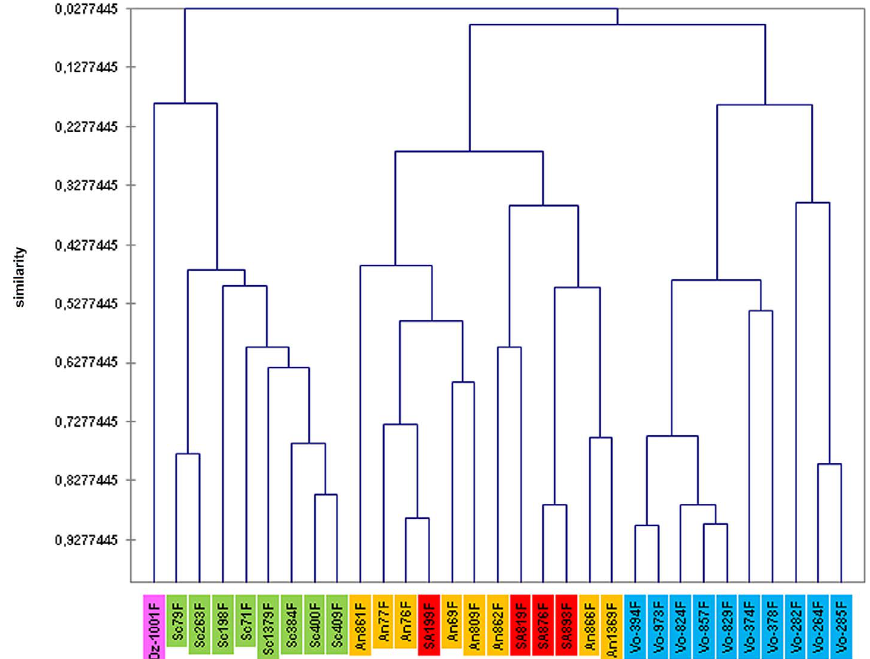
Figure 7. Hierarchical clustering based on morphometrical characters of females belonging to the following species Sc = Se. sclerosiphon ; An = Se. anka ; SA = Se. cf. anka ; Vo = Se. vol fi n. sp.; Oz = Se. ozbeli n.